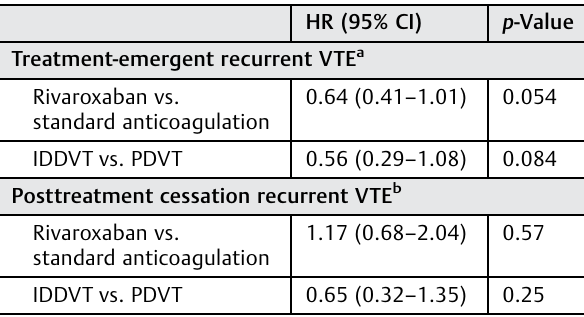
Table 4 Adjusted hazard ratios for on-treatment and off- treatment recurrent VTE in patients with IDDVT or PDVT treated with rivaroxaban or standard anticoagulation in safety analysis set HR (95% CI) p